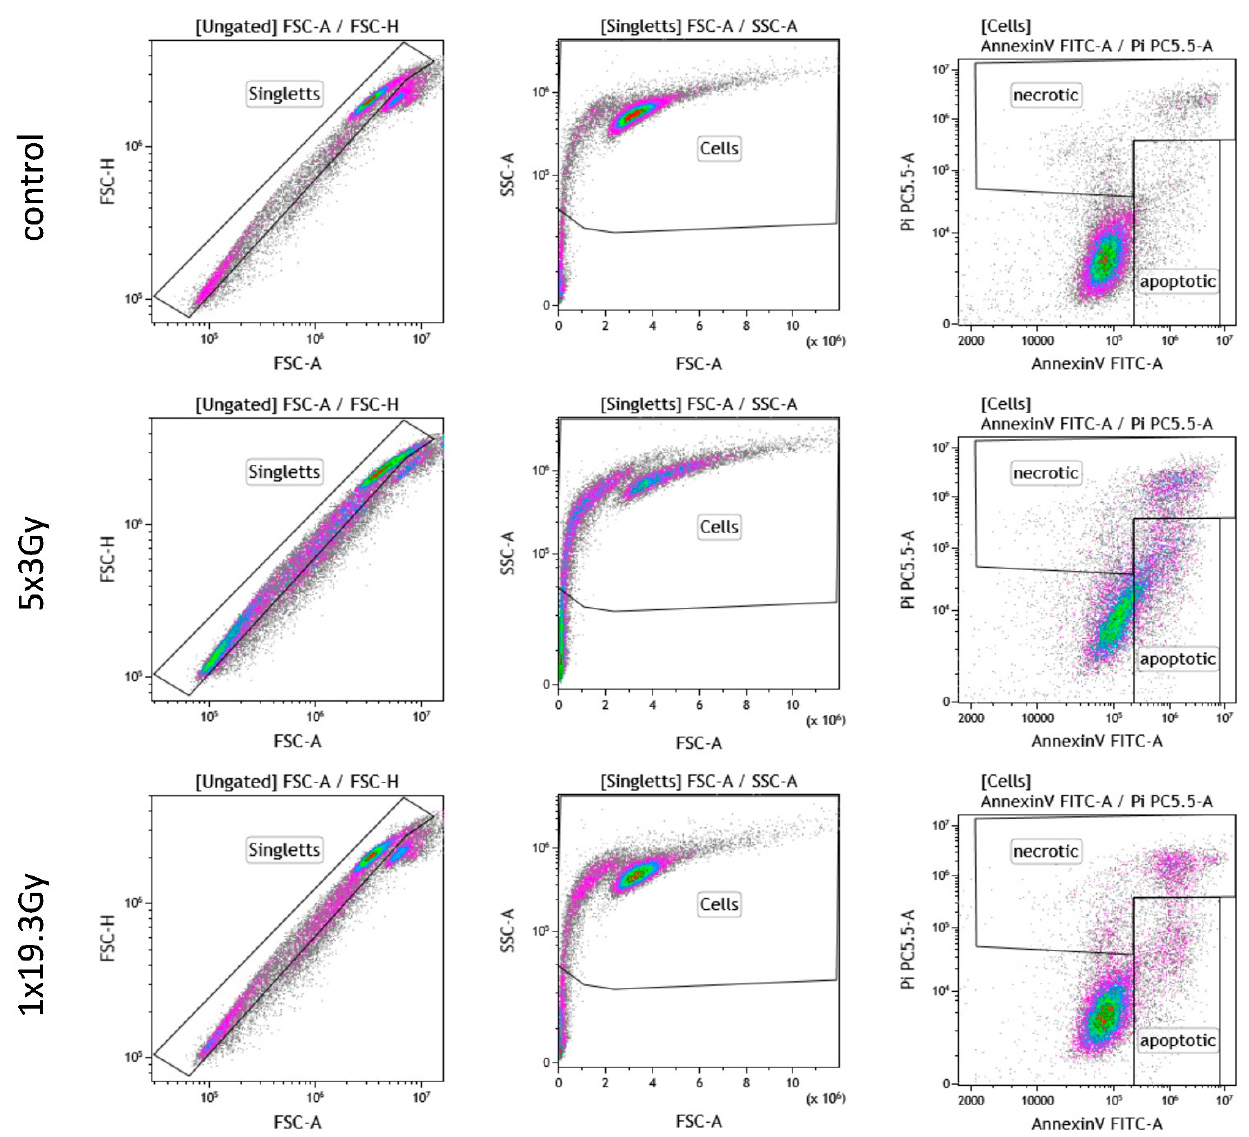
Figure A1. Gating strategy for cell death measurement with AnnexinV/Propidium iodide staining. Left : Forward-side- scatter to separate single cells from cell clusters. Middle : Separation of cells from cell debris. Right : Separation of the different cell death forms with AnnexinV-FITC and Propidium iodide. Primary necrotic cells: Ax+/Pi++, early apoptotic cells: Ax+/Pi-, late apoptotic cells: Ax+/Pi+. Shown is the gating strategy using an exemplary staining for HSC-4 cells that were evaluated on day 7 of the experiment.